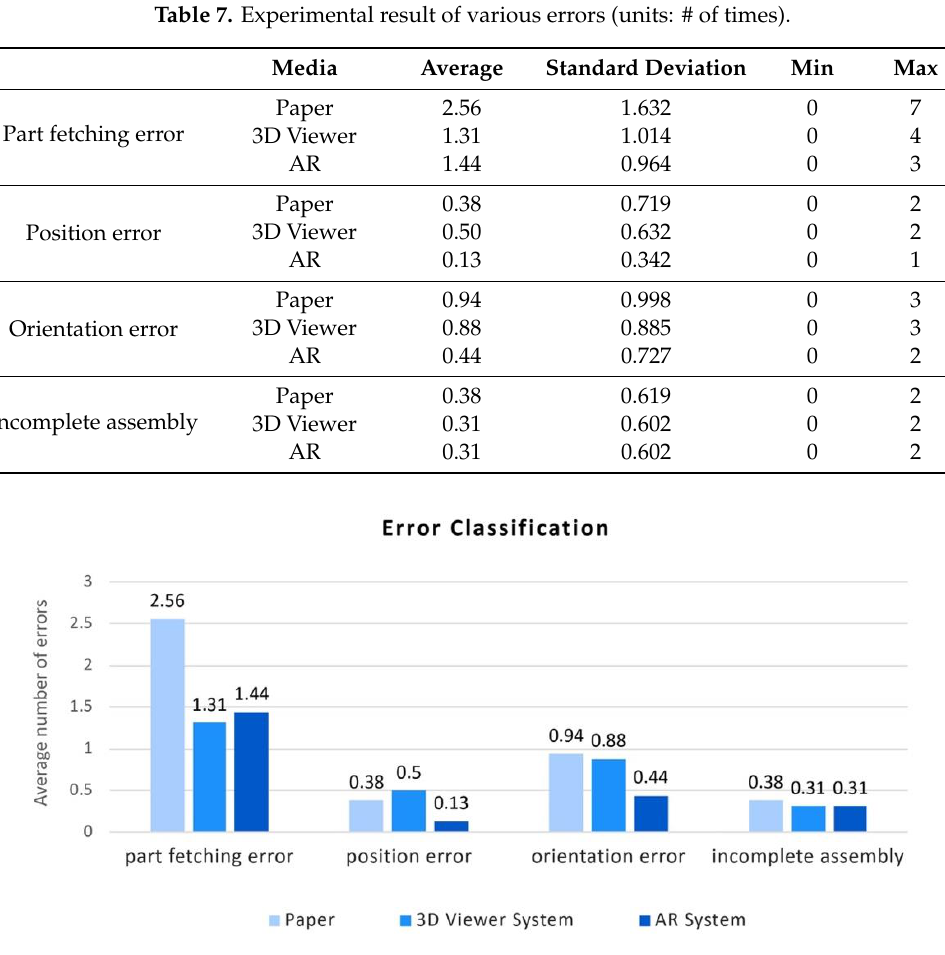
Figure 13. Numbers of various errors for the three forms.